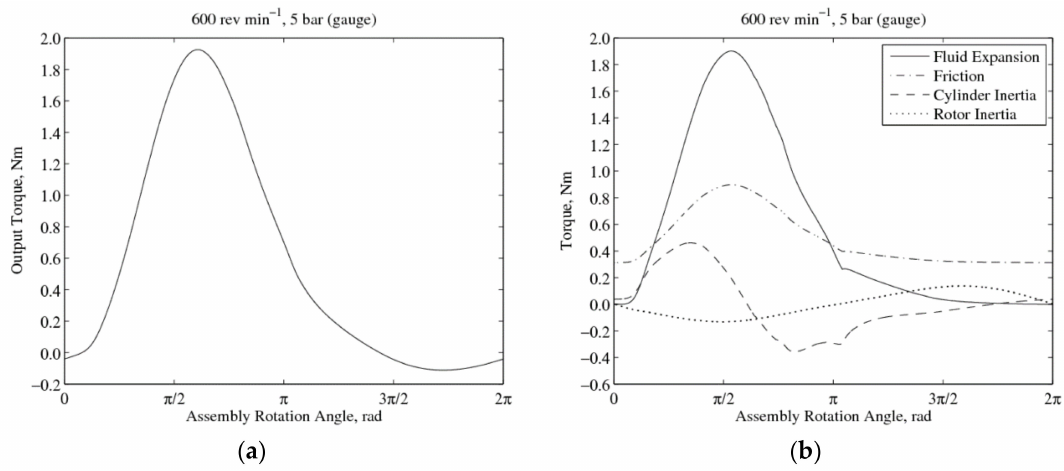
Figure 12. Type-II revolving vane expander performance: ( a ) Output torque; ( b ) Torque